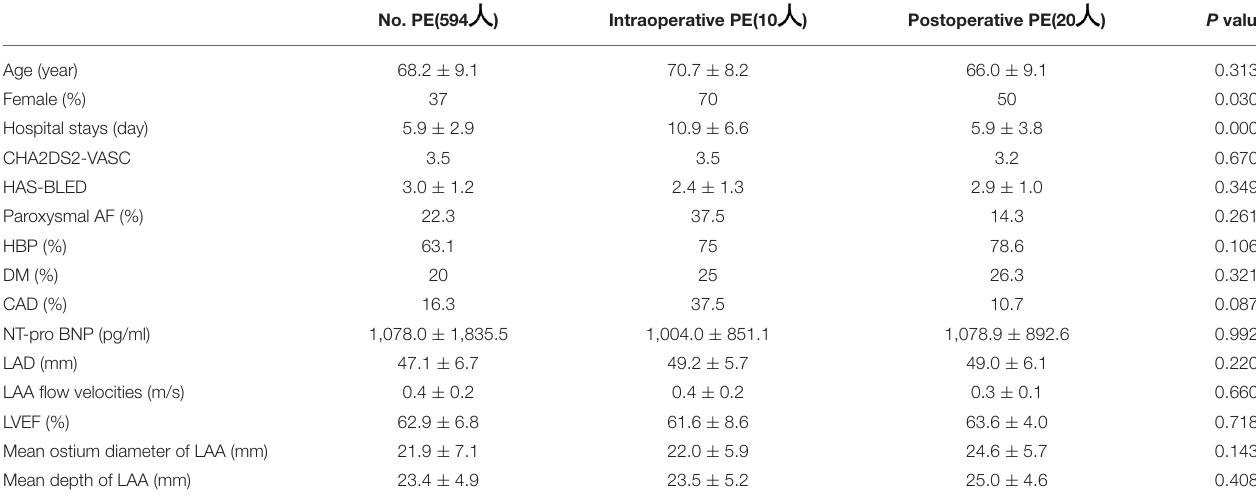
TABLE 1 | The baseline data for pericardial effusion in the perioperative